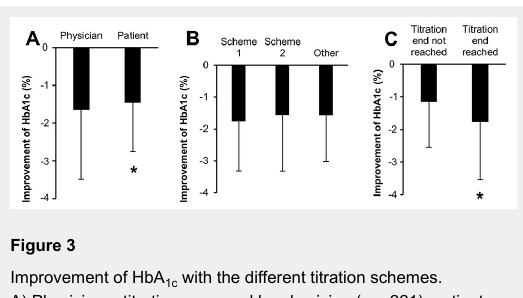
Figure 3 Improvement of HbA 1c with the different titration schemes. A) Physician = titration managed by physician (n = 221), patient = titration managed by patient (n = 91); p = 0.049, adjusted for baseline HbA 1c . B) Improvement of HbA 1c in the different titration groups. 1 = change of 2 U every 3 days (n = 58), 2 = weekly adjustment (n = 230), 2 = other titration scheme (n = 27), p = not significant, adjusted for baseline HbA 1c . C) Titration end not reached (n = 87), Titration end reached (n = 228); p <0.001, adjusted for baseline HbA 1c